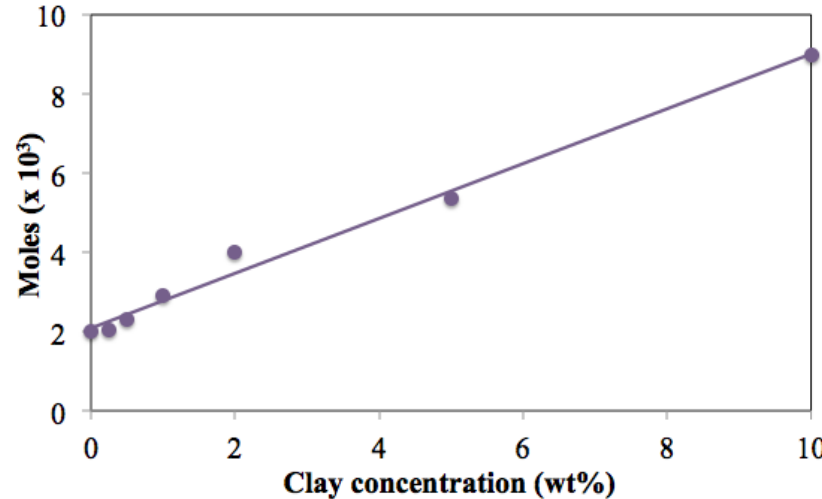
Figure 12. Dependence of the moles of crosslinks in XPU and XPUC on wt.% clay. Increasing wt.% clay increases the physical crosslink density denoted as the moles of crosslinks. At the y-axis intercept (0 wt.% clay), the contribution to the total crosslink density from chemical crosslinking due to the reaction of glycerin with isocyanate, MDI is determined to be about 2 × 10 − 3 moles. This model predicts the magnitude of both chemical and physical crosslinking in a chemically crosslinked polyurethane-clay nanocomposites.